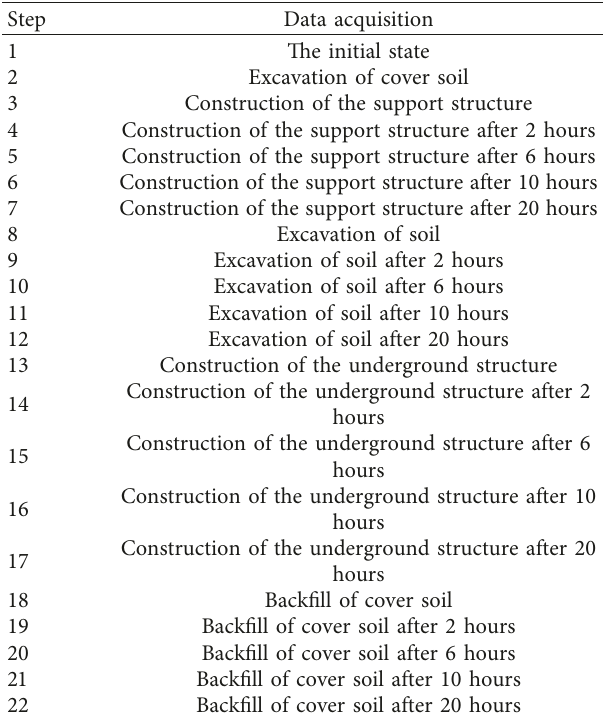
Table 3: The steps of soil pressure sensors data